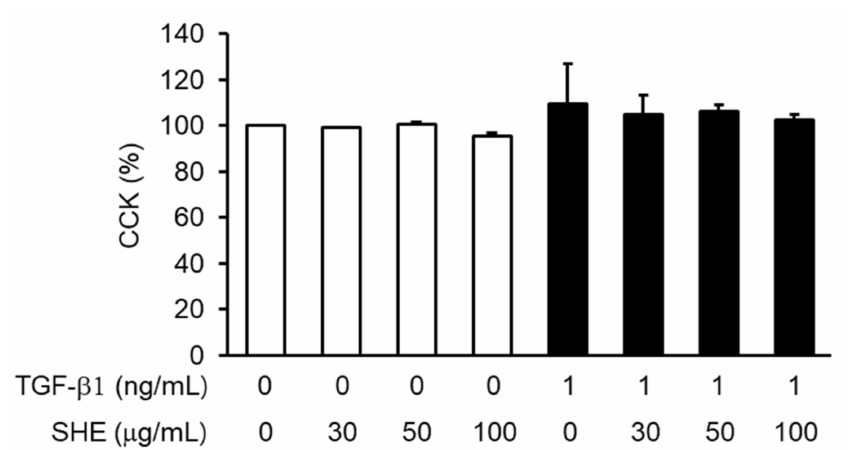
Figure 1. The effect of Sargassum horneri ethanol extracts (SHE) on nasal polyp–derived fibroblasts (NPDF) viability. The cells were treated with various concentrations (30, 50, and 100 µ g/mL) of SHE for 24 h. Cell viability was assessed using the Cell Counting Kit-8 (CCK-8) assay, and the results are expressed as the percentage of surviving cells relative to the untreated cells. Each value indicates the mean ± standard error of the mean (SEM) and is representative of results obtained from three independent